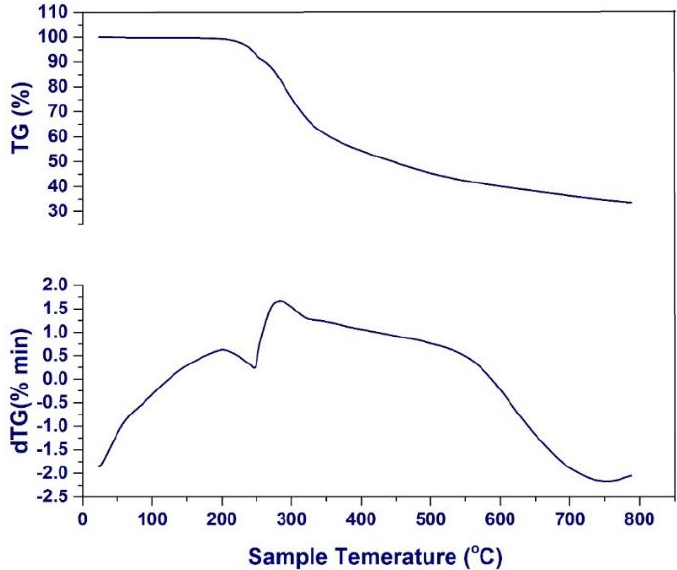
Figure 4. Thermal analysis (TGA/dTGA) of compound 4.